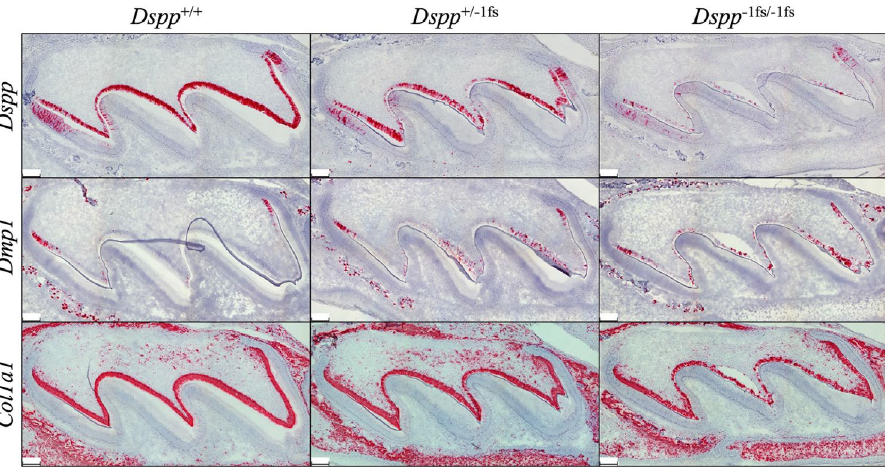
Figure 6. Expression of Dspp, Dmp1, and Col1a1 mRNA in the wild-type, Dspp + / −1fs , and Dspp −1fs / −1fs Mice. In situ hybridization/RNAscope is performed on 3-day-old Dspp −1fs mouse maxillary 1 st molars to show mRNA in red. Upper row In the wild-type mice, Dspp mRNA is observed in the odontoblasts and presecretory and early secretory ameloblasts. Dspp mRNA in both Dspp +/−1fs and Dspp −1fs/−1fs mice are reduced in both odontoblasts and ameloblasts. The reduction is more apparent in the Dspp −1fs/−1fs mice. Middle row Dmp1 is mainly expressed dentin mineralization is elevated. Lower row Col1a1 expression by the odontoblasts is mildly weaker in the Dspp +/−1fs and Dspp −1fs/−1fs mice. Scale bar: 100